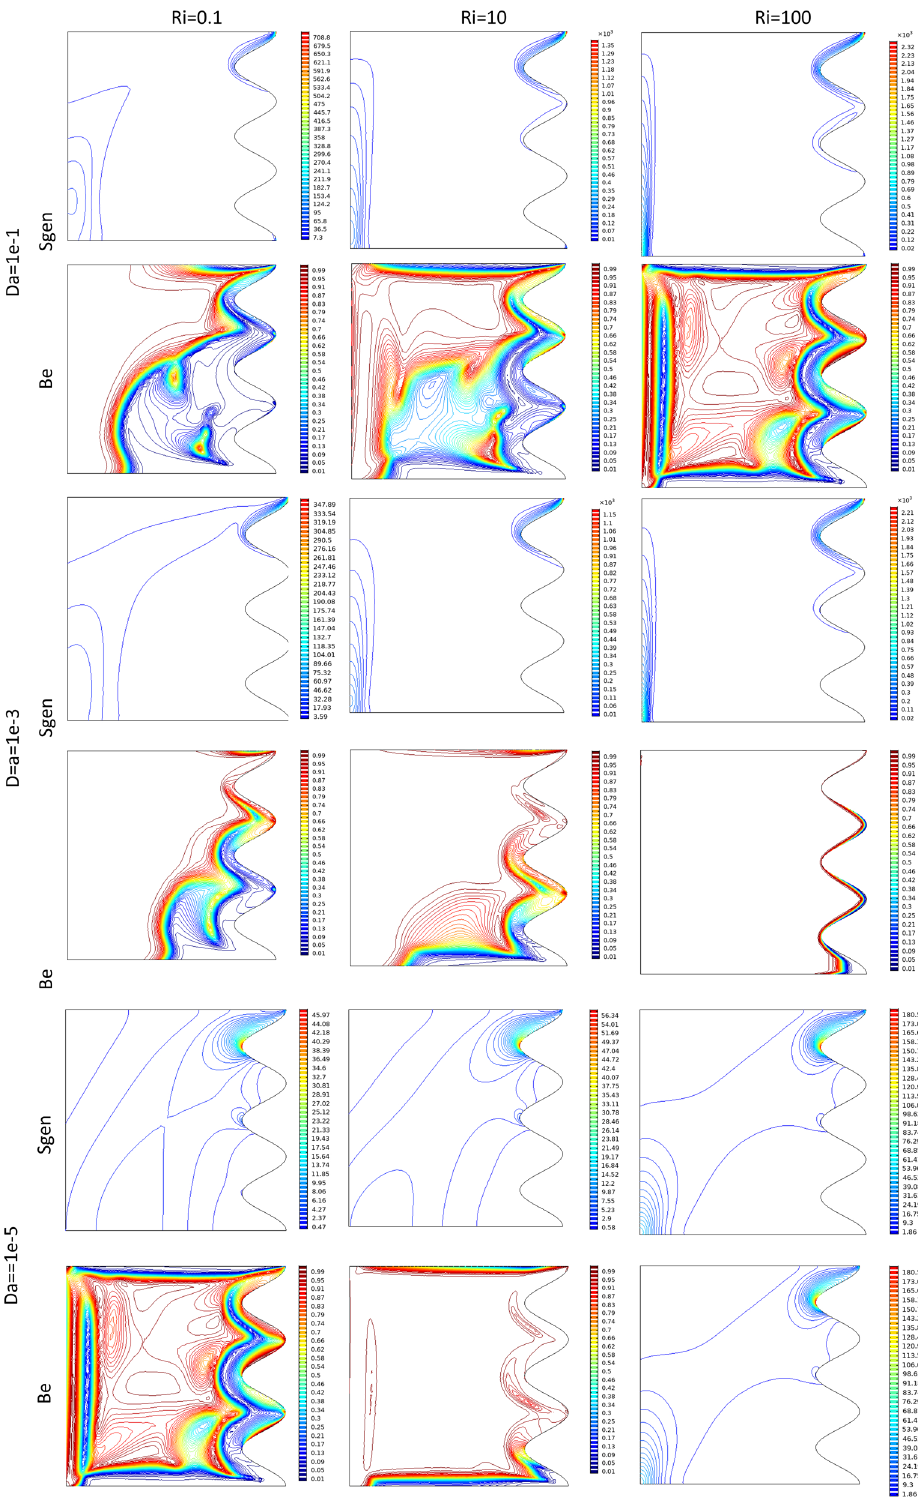
Figure 7. Bejan number and Sgen at different Da and Ri numbers when Re = 100, λ = 5, φ = 0.02, Ha = 20, γ = 45, A = 0.1, N = 3 for case